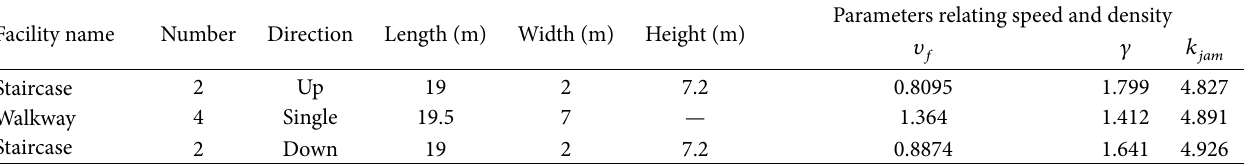
Table 1: Flow facilities and their parameters for fundamental diagrams.